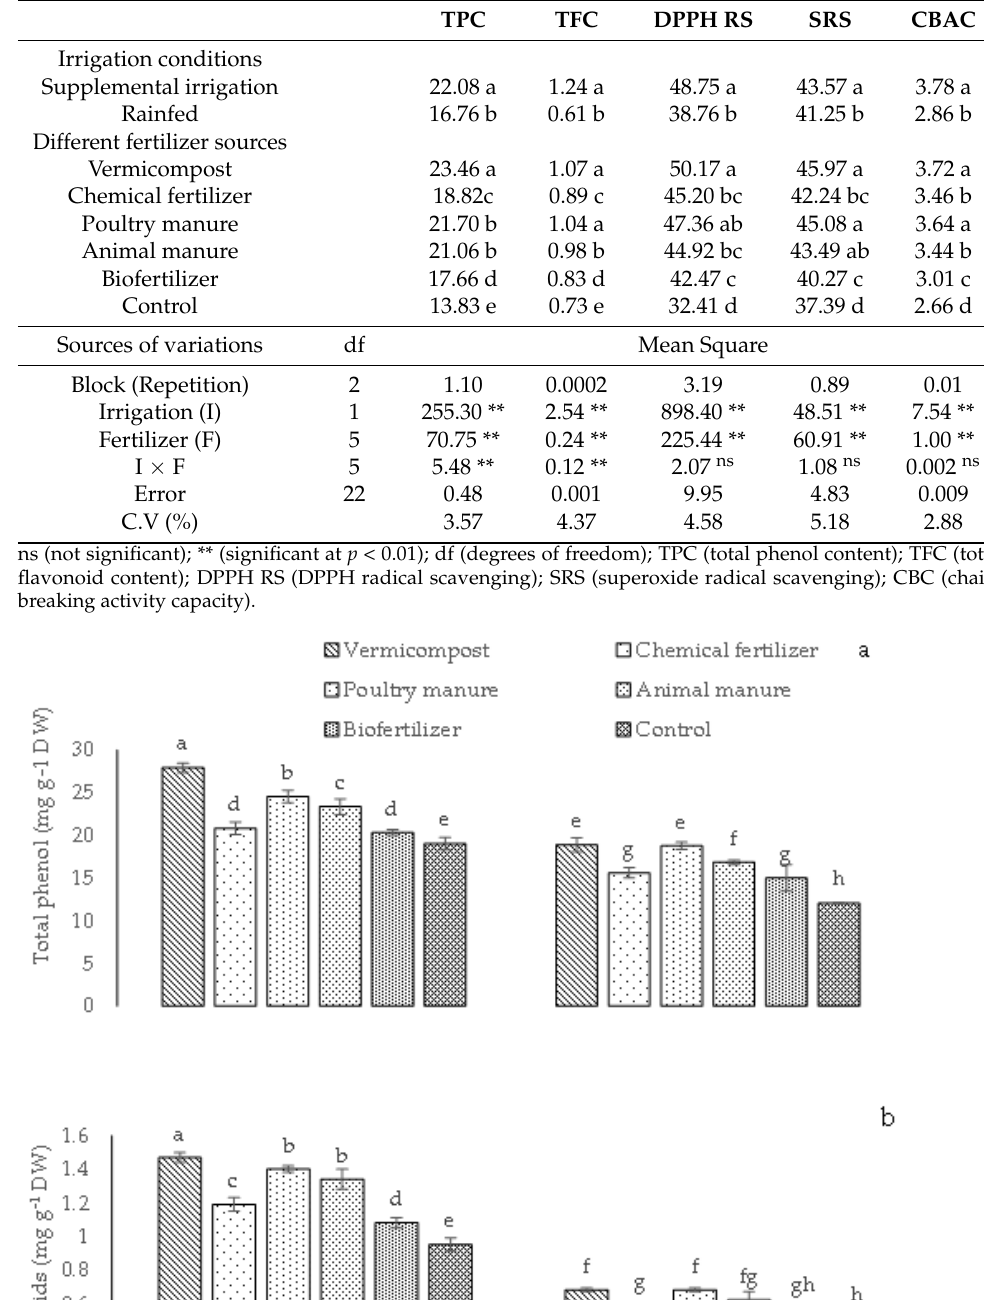
Table 2. Analysis of variance and comparison of means of antioxidant activity traits of dragon’s head plants in response to irrigation conditions (I), different fertilizer sources (F), and their interaction (I × F). Different letters in each column indicate significant differences according to Tukey’s HSD test ( p < 0.05).